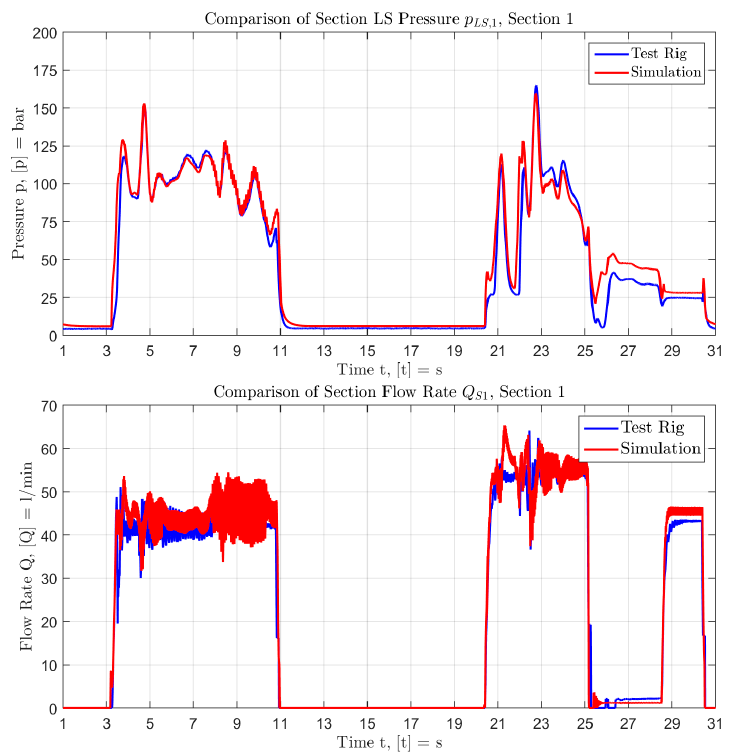
Figure 14. Results Section 1: LS Pressure ( top ), Flow Rate ( bottom ) [9]. Reproduced with permission from the publisher.